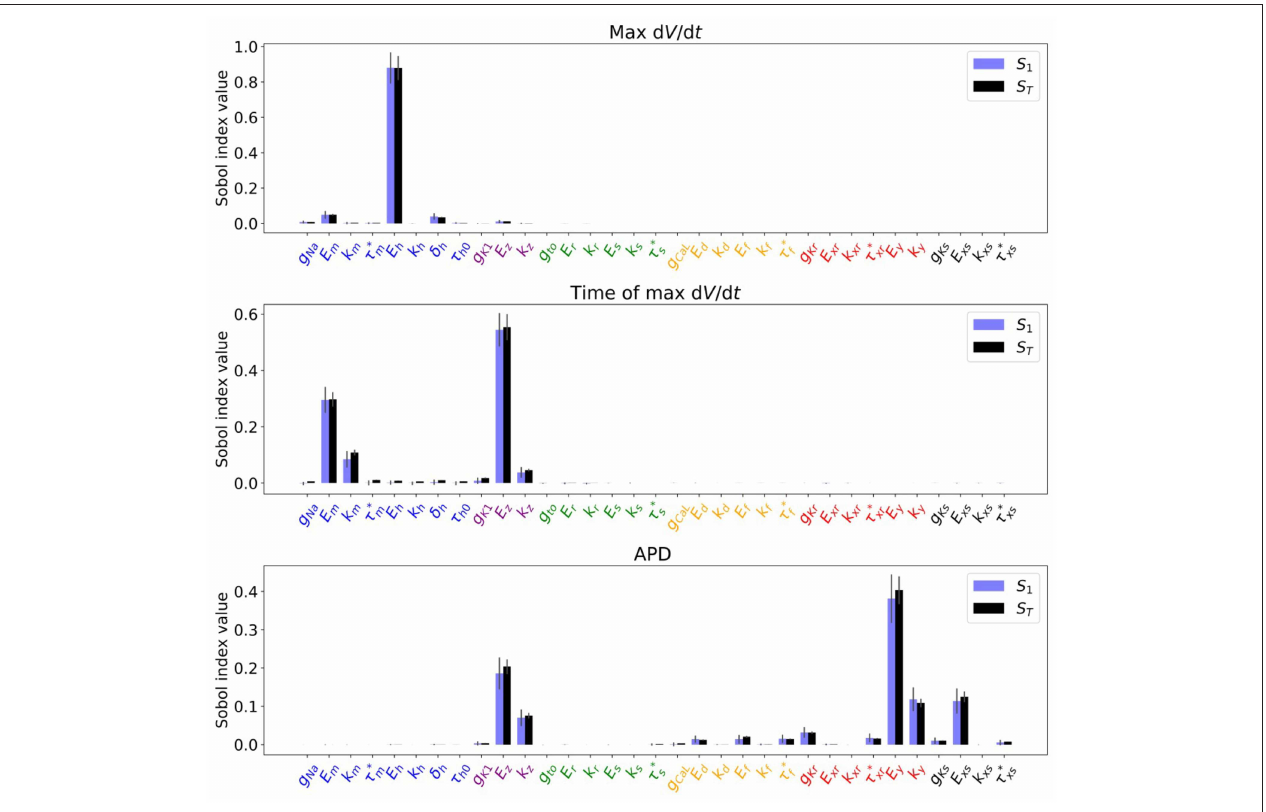
FIGURE 4 | Sobol sensivitivity indices ( S 1 : first-order; S T : total) for selected QOIs (MaxUpstrokeVelocity, TimeOfMaxUpstrokeVelocity, APD), with ˆ σ = 1 % , which represents a small amount of uncertainty in all cell model parameters. Solid lines are error estimates in the index.